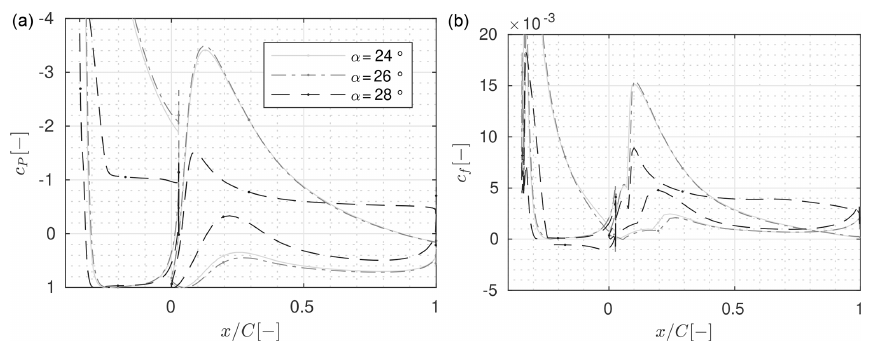
Figure 16. Stall progression for configuration C ∗ optimized for maximum glide ratio from CFD for the clean configuration: in terms of (a) pressure and (b) skin friction coefficients.